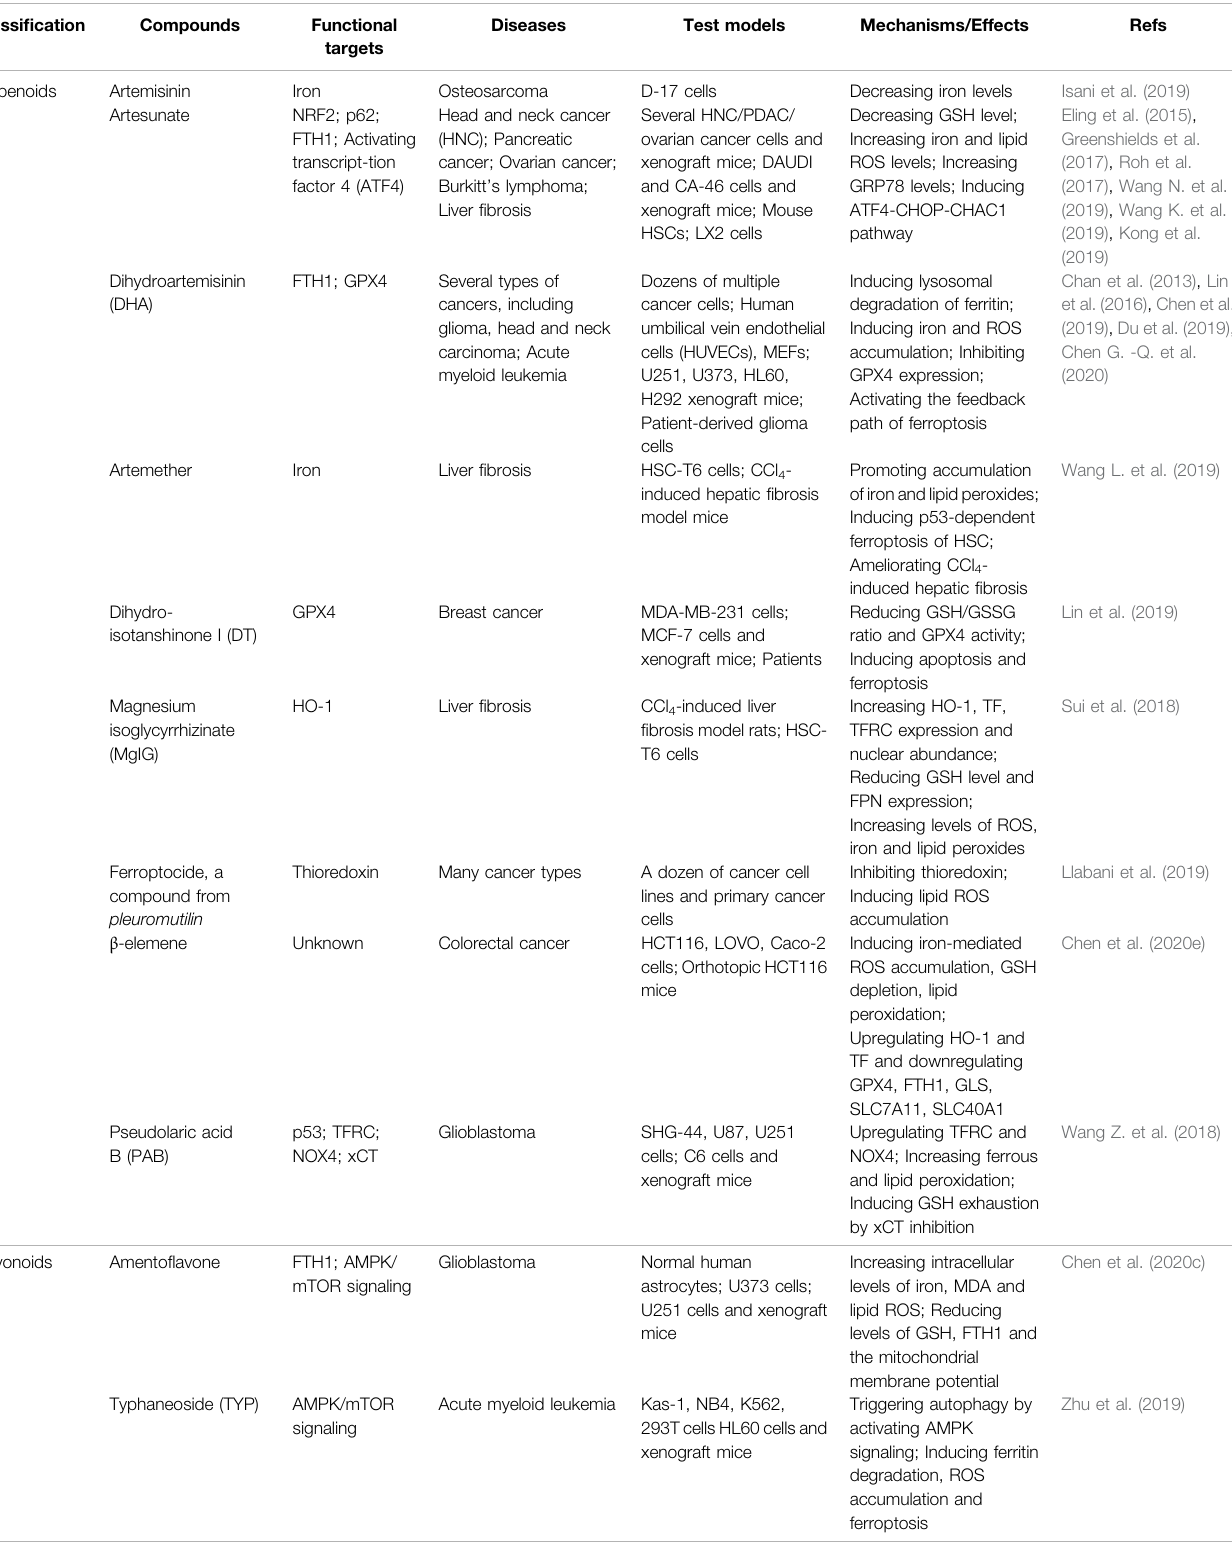
TABLE 3 | Natural products induced